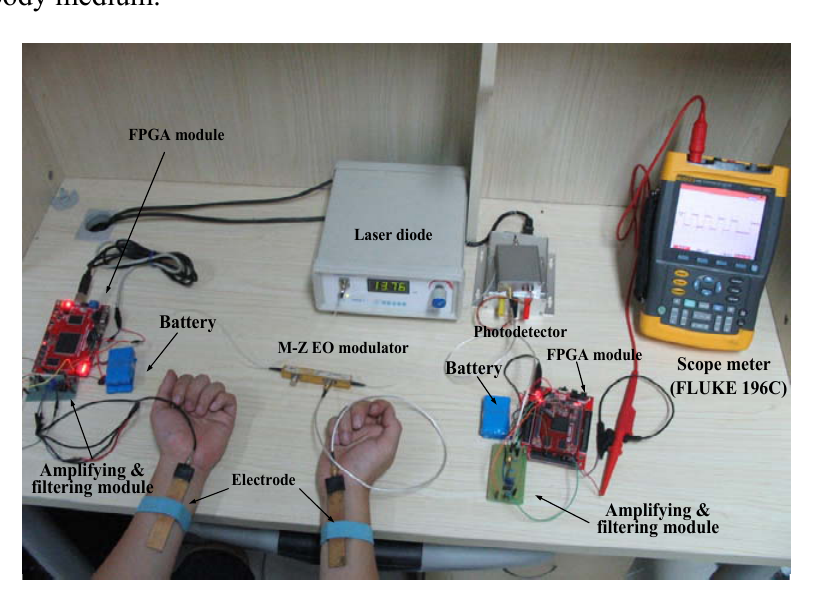
Figure 7. Experiment device used for the signal transmission experiments of BSN based on human body